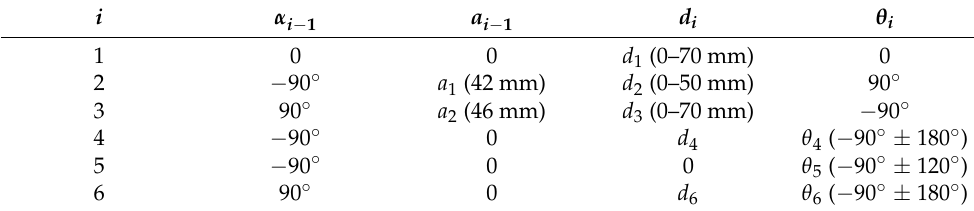
between joints along the z -axis, a i is the length of the link between two joints, and d i is the distance between the z -axis perpendiculars between joints. Table 4 lists the corresponding parameters between the joints in the 6 DoF micromotion stage. d 1 , d 2 , and d 3 are the sliding transformations of the corresponding joints. Table 4. Parameters related to each joint of the six DoF micromotion stage.